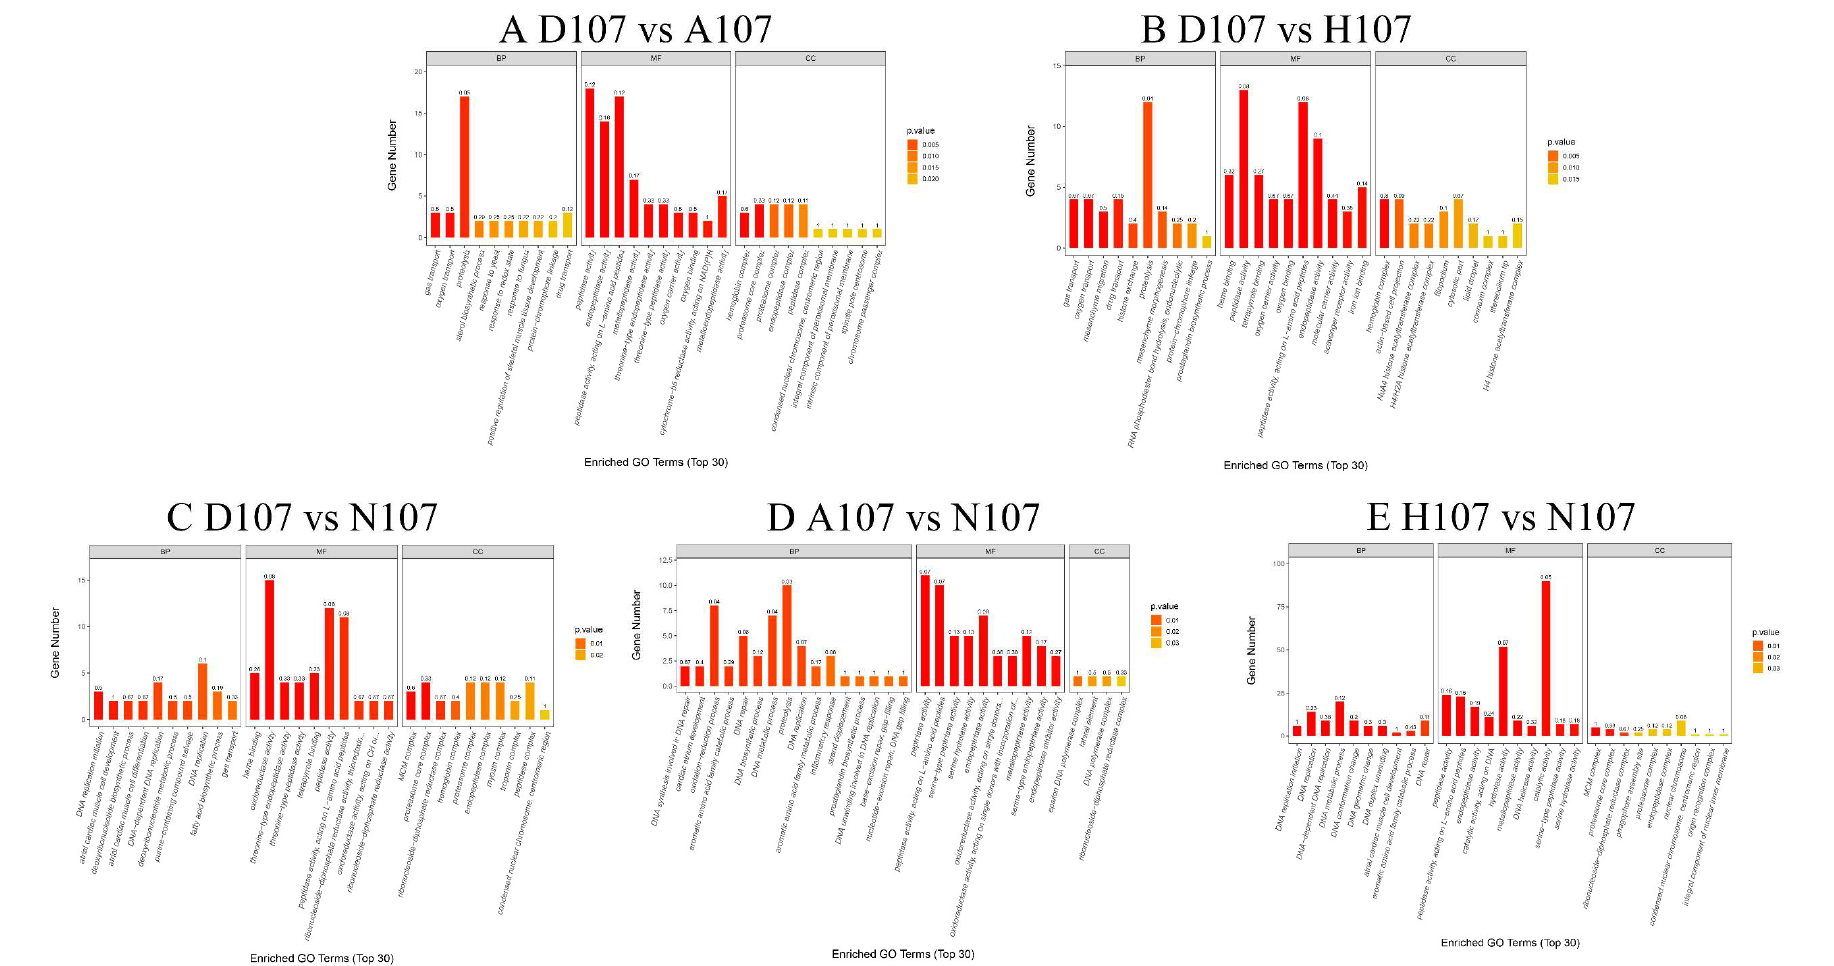
Figure 4. GO enrichment analysis of the DEGs under hypoxia and acidification stress.